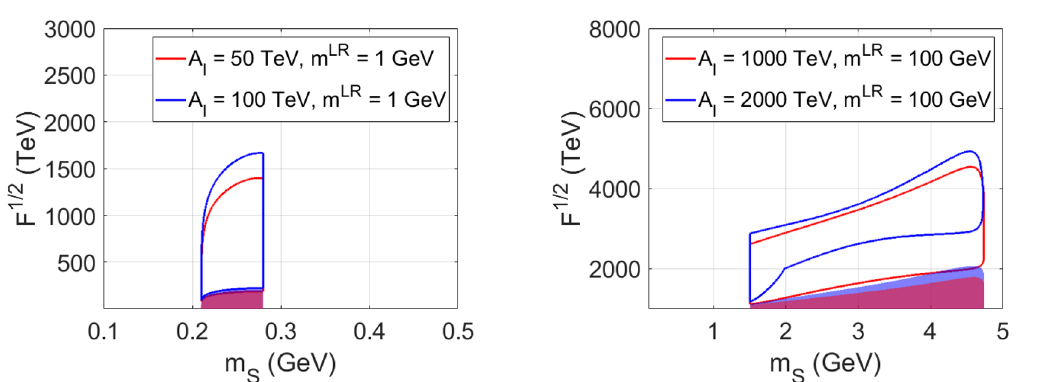
Figure 17 . FASER-I sensitivity to light sgoldstinos produced in K-mesons, where we take m LR m LR = m LR = 10 GeV (left plot) and η 0 -meson (right plot) decays due to flavor violating couplings. D 21 Sgoldstino decays into muon pair inside the detector volume. Shaded areas correspond to restrictions √ √ from table 1. In the regions where F < A l we set A l = F .